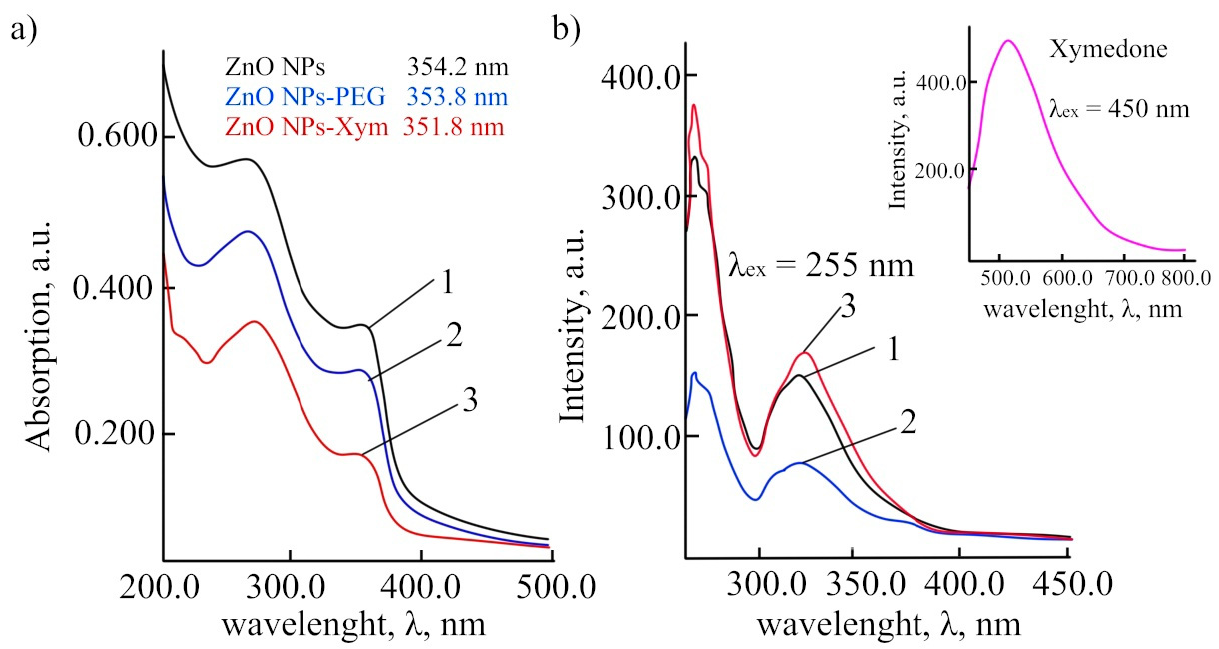
Figure 2. UV-vis ( a ) and fluorescence ( b ) spectra of ethanol dispersions of ZnO NPs of samples: ZnO NPs (curve 1); ZnO NPs–PEG (curve 2); ZnO NPs–Xym (curve 3). The insert shows fluorescence spectrum of xymedone.